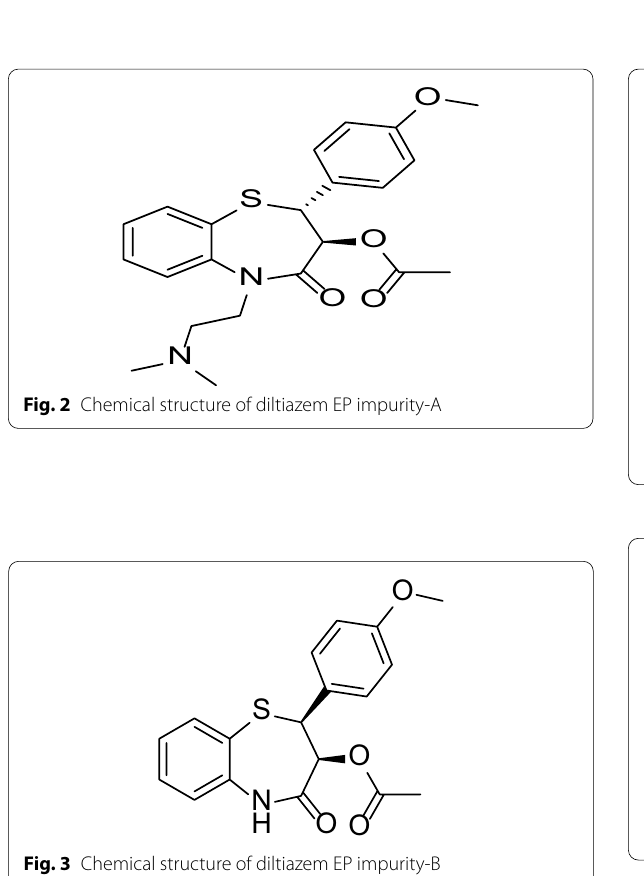
Fig. 3 Chemical structure of diltiazem EP impurity-B